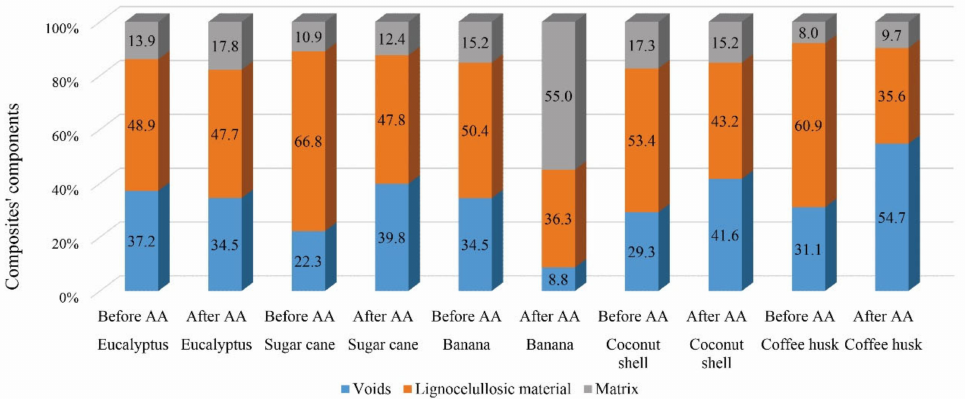
Figure 4. Composite components obtained through supervised image analysis of the evaluated lignocellulosic material before and after the accelerated ageing (AA) process.